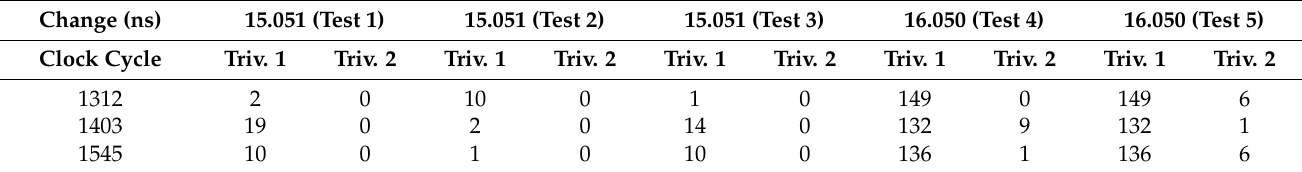
Table 9. Number of faults injected into the standard Trivium cipher when the control signals are changed. Change (ns)